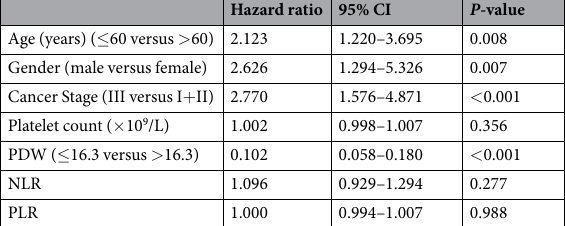
Table 4. Multivariate analysis of overall survival in patients with lung cancer. Variables that showed a P value < 0.10 in univariate analysis were included in a multivariate Cox proportional hazards regression